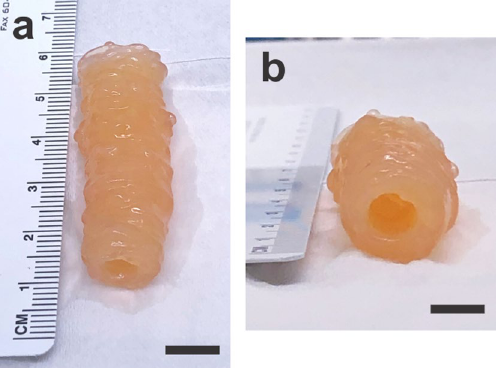
Figure 10. Physiologically relevant length engineered vessel. A 5 cm long adventitia vessel was created, demonstrating the capability of the Ring Stacking Method to create engineered vessels in lengths suitable for